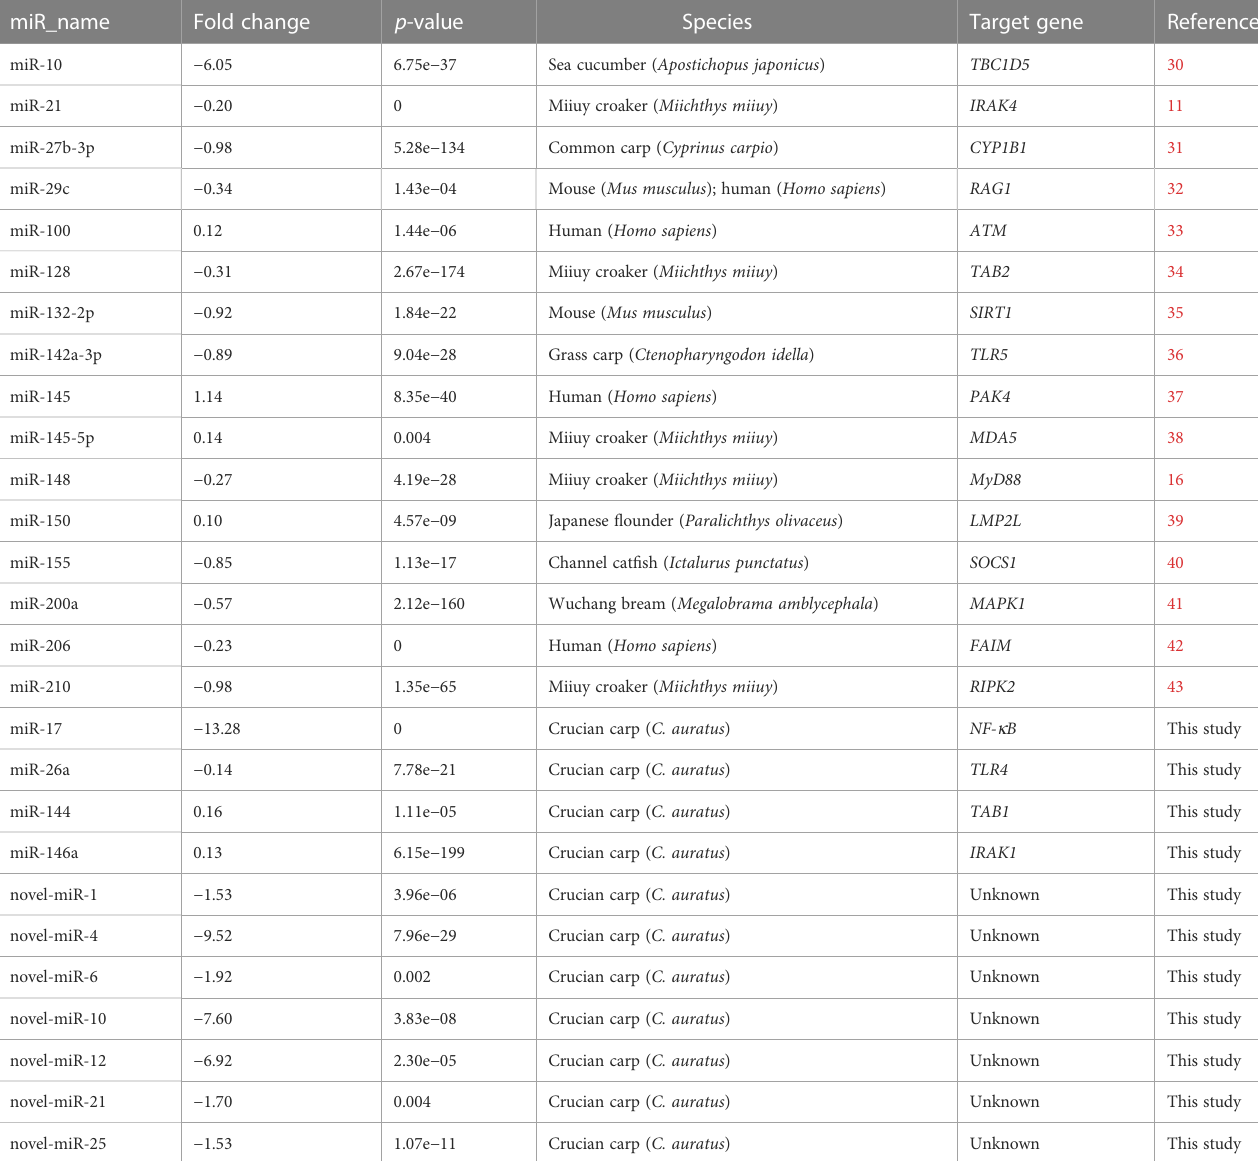
TABLE 2 Differential expression of the known and unknown miRNAs in the gills of Carassius auratus challenged with Aeromonas hydrophila